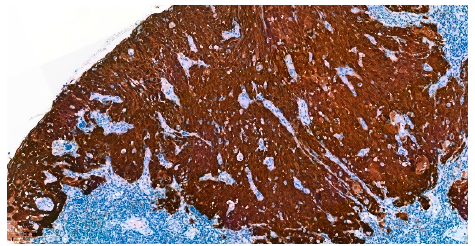
Figure 1 . Immunohistochemistry of p16 - positive OPSCC ( 100× ). Figure 1. Immunohistochemistry of p16-positive OPSCC (100 × ).